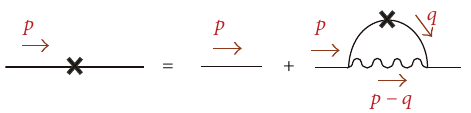
Figure 5: Gap equation for QED in the ladder